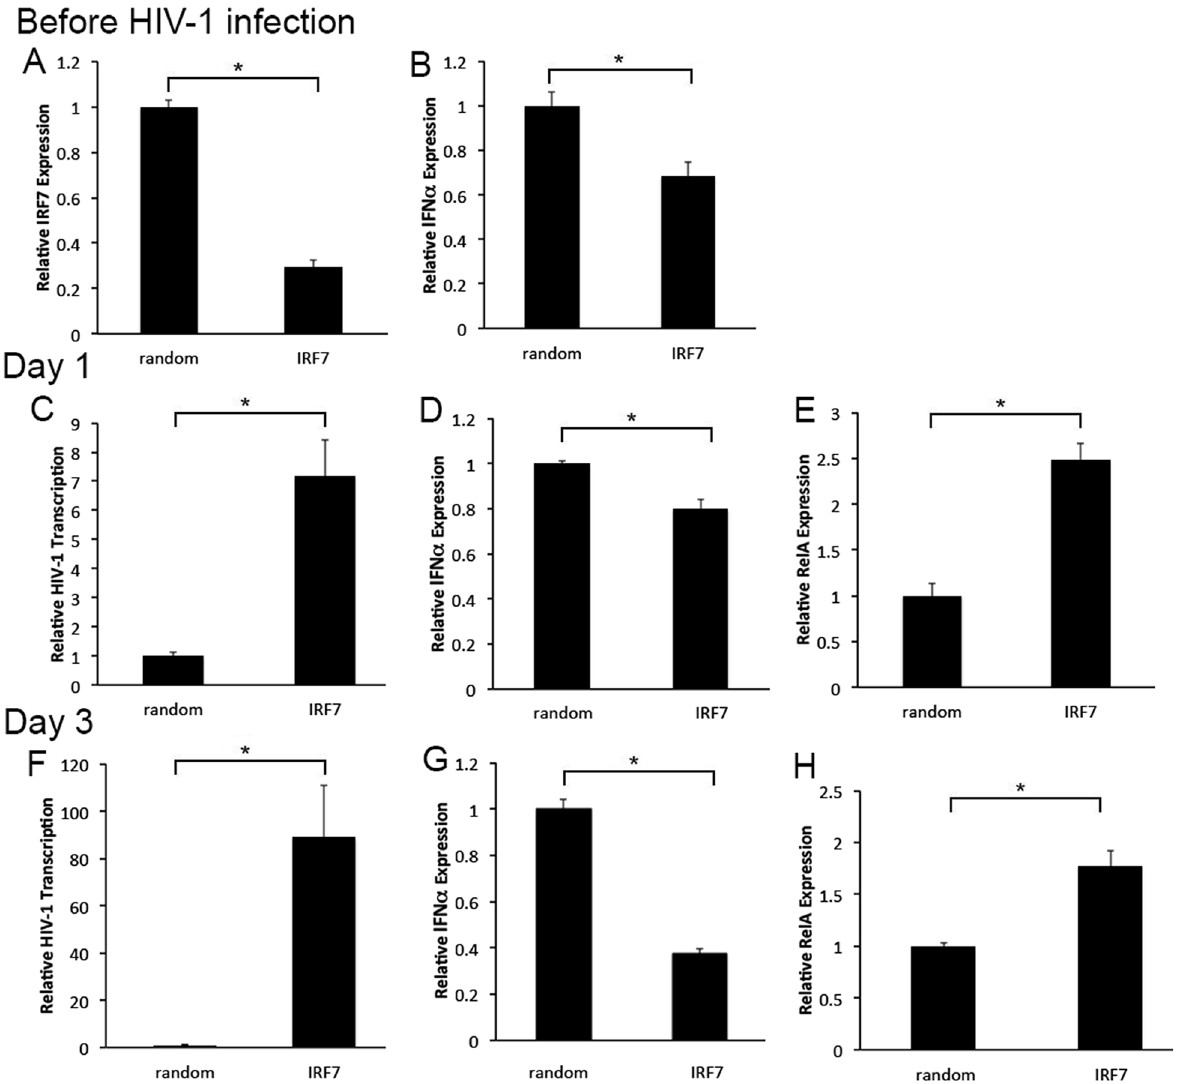
Fig 5. Decreasing IRF7 expression enhances HIV-1 and RelA transcription. (A) IRF7, (C and F) HIV-1, (B, D and G) IFN α and (E and H) RelA transcription in HIV-1-infected cervical tissues treated with random and IRF7 targeting siRNA were quantified by RT-PCR before (A) and (B) and on days 1 (C, D and E) and 3 (F, G and H) after HIV-1 infection. All data was normalized to GAPDH. Results were consistent among four donors and are shown as the mean ± STDEV from one representative experiment with each condition tested in triplicate. * p < 0.05 for tissues treated with random and IRF7 targeting